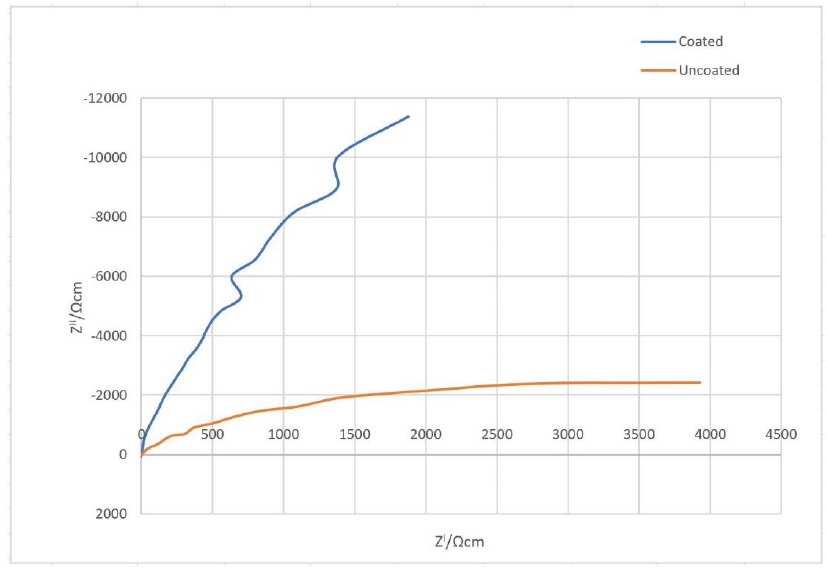
Figure 3. EIS for TiN coated and uncoated SS316L [49].